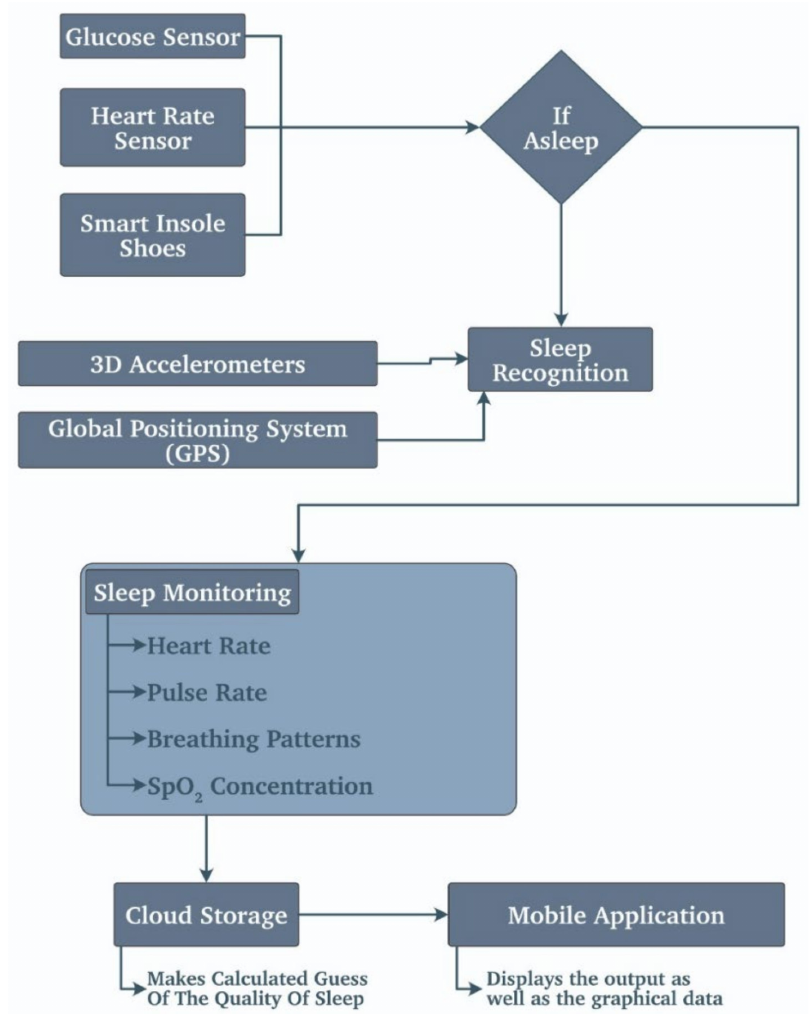
Figure 9. Sleep monitoring in real-time using